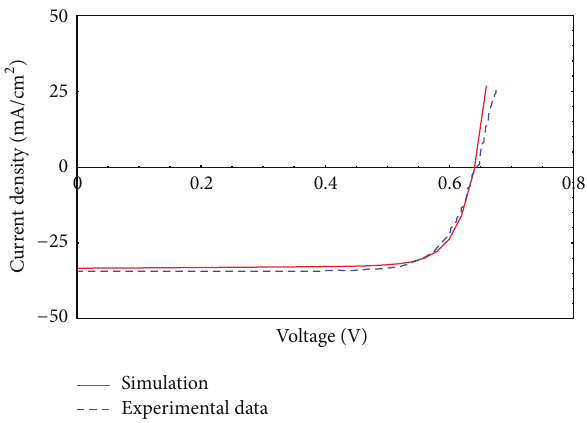
Figure 1: Structure of CIGS-based solar cells. Figure 2: Comparison between the photocurrent density-voltage ( J - V ) curves for the simulated (red line) and the reported experi- mental data (blue line)